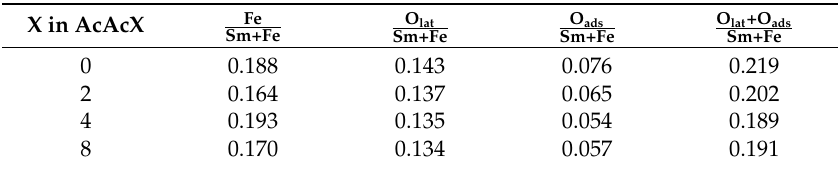
Figure 13. XPS spectra of the SmFeO 3 thin-film device prepared from AcAc0, 2, 4 and 8 precursors sintered at 750 ◦ C; ( a ) Fe 2p and ( b ) O 1s. Table 1. Ratios of the elements on the surface of the SmFeO 3 thin-film prepared from AcAc0, 2, 4 and 8 precursors sintered at 750 ◦